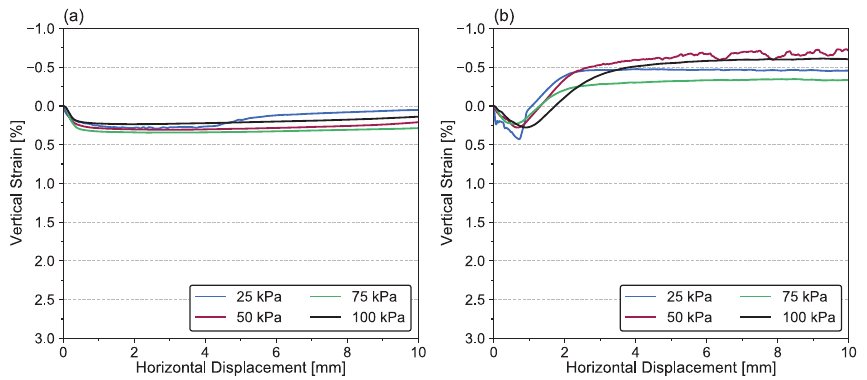
Figure 9. Vertical strain as a function of horizontal displacement from interface direct shear test on JEZ-1-steel plate: ( a ) smooth and ( b ) rough surfaces.